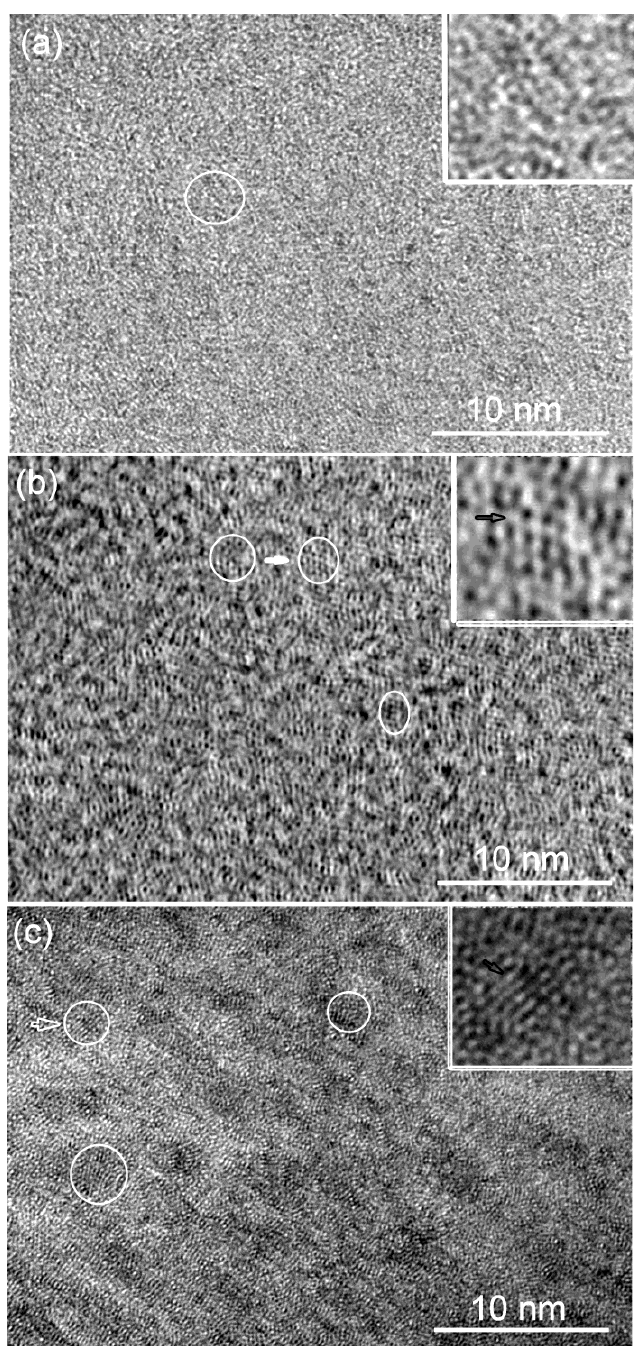
Figure 7. (a) HRTEM image of Pd (b) HRTEM image of Pd Pd Ni Si P BMG with a diameter of 2 40 40 6 14